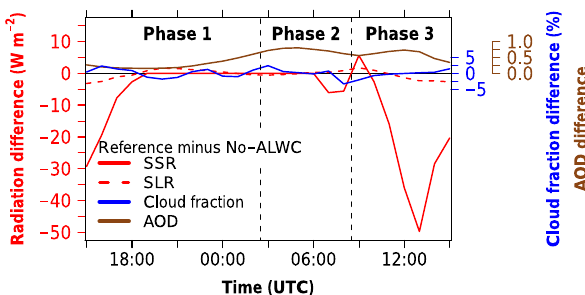
Figure 13. Diurnal cycle of the difference between the reference and No-ALWC with respect to SSR (red solid, Wm − 2 ), SLR (red dashed, Wm − 2 ), domain-wide cloud fraction (blue, %) and AOD (brown) as a median over the Ivory Coast (7.5–3 ◦ W, 4–10 ◦ N) be- tween 2 July 15:00UTC and 3 July 15:00UTC. The vertical dashed lines indicate the three phases introduced in Fig. 3. Note the color code of the different